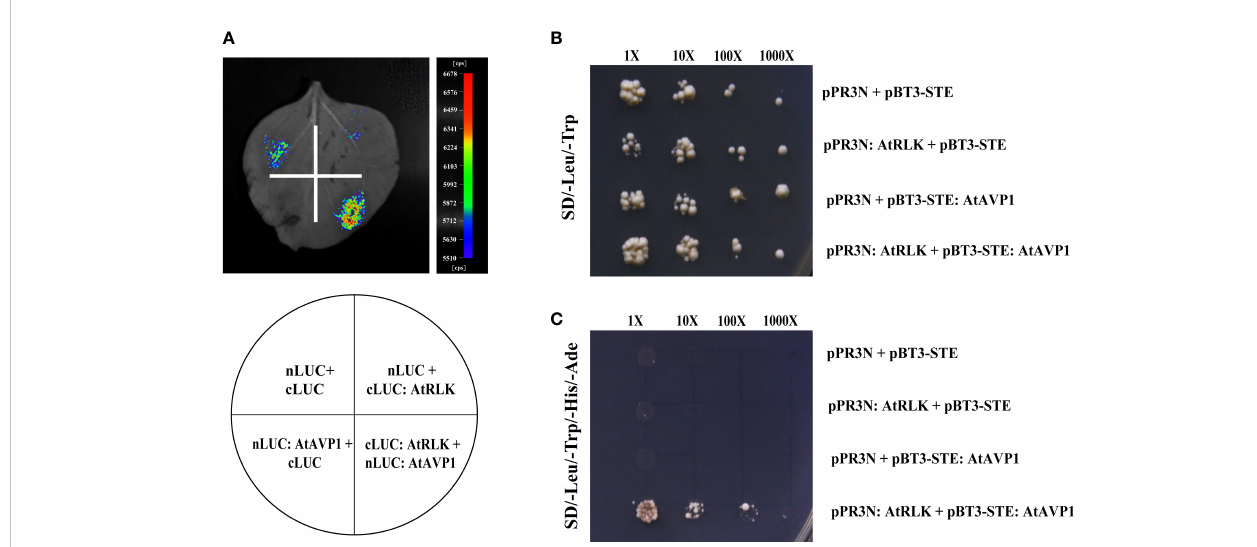
FIGURE 5 Identi fi cation of AtAVP1 interactions with AtRLK (A) Identi fi cation of an interaction between AtRLK and AtAVP1 using a luciferase complementary imaging (LCI) assay. The nLUC : AtAVP1/cLUC : AtRLK and negative control constructs were transfected into Agrobacterium tumefaciens and then injected into four different regions of a tobacco leaf. The leaves were analyzed for luminescence signal by Night SHADE LB 985. (B, C) Identi fi cation of an interaction between AtRLK and AtAVP1 using a yeast two-hybrid system. (B) The pBT3-STE : AtAVP1/pPR3N:AtRLK and negative control constructs were co- transformed into yeast cells and grown on SD/-Leu-Trp double de fi ciency medium. (C) The co-transformed pBT3-STE : AtAVP1/pPR3N:AtRLK and negative control into yeast cells were grown on SD/-Leu-Trp-His-Ade selective medium at 1×, 10×, 100×, and 1000× dilution gradients to test the